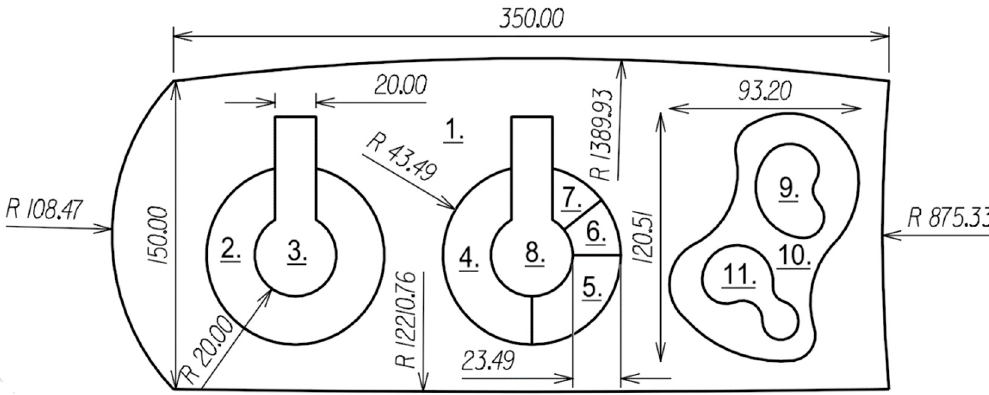
Figure 9. Test object containing arcs of different radii (including parcel numbering), dimensioning was made to indicate the proportions of the test parcels. Table 1. Summary of arc parameters and received linear data after approximation (Figure 8).